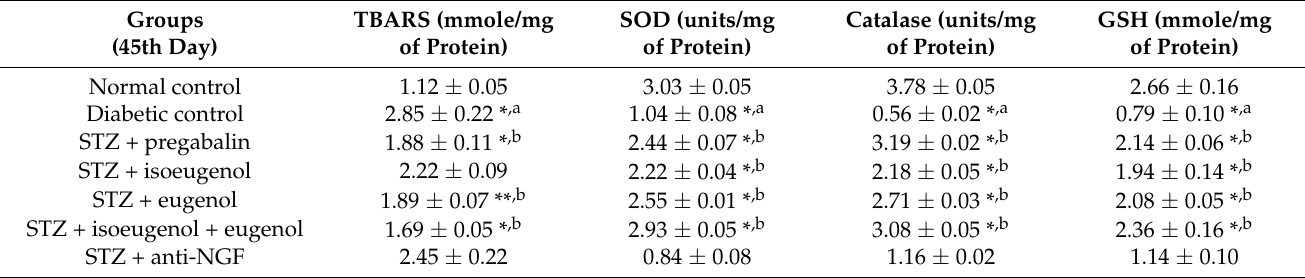
Table 2. Effect of isoeugenol, eugenol, and their combination on antioxidant parameters. Groups